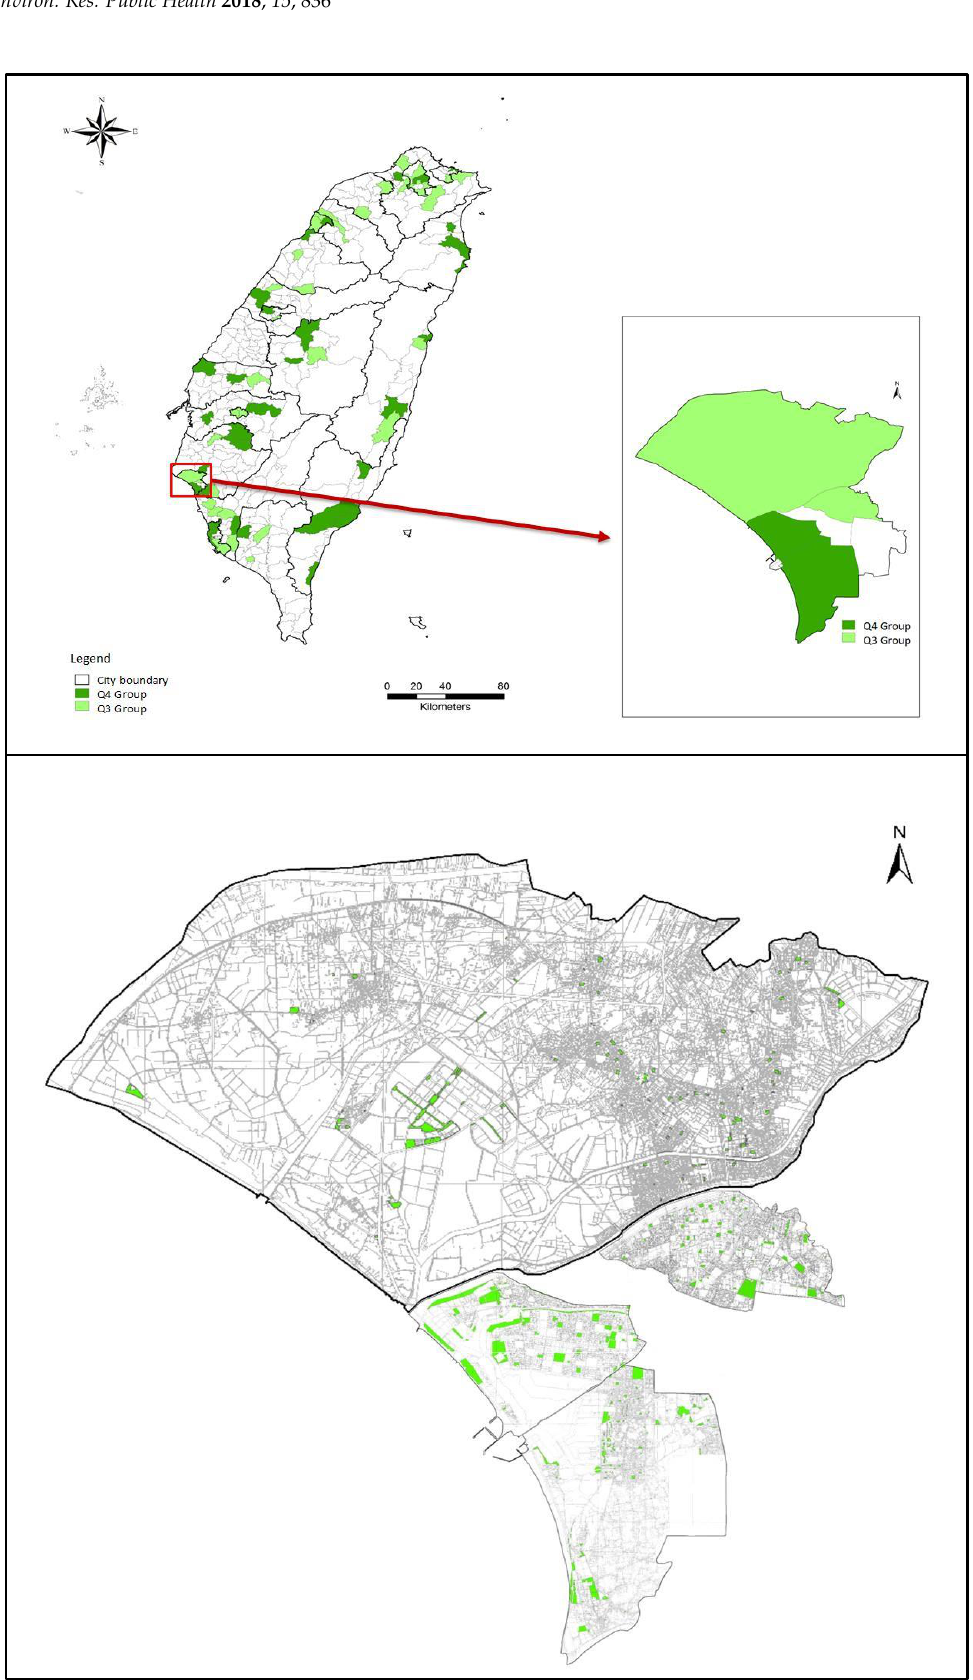
Figure 4. The distribution of parks and green spaces in the Q3 and Q4 groups.